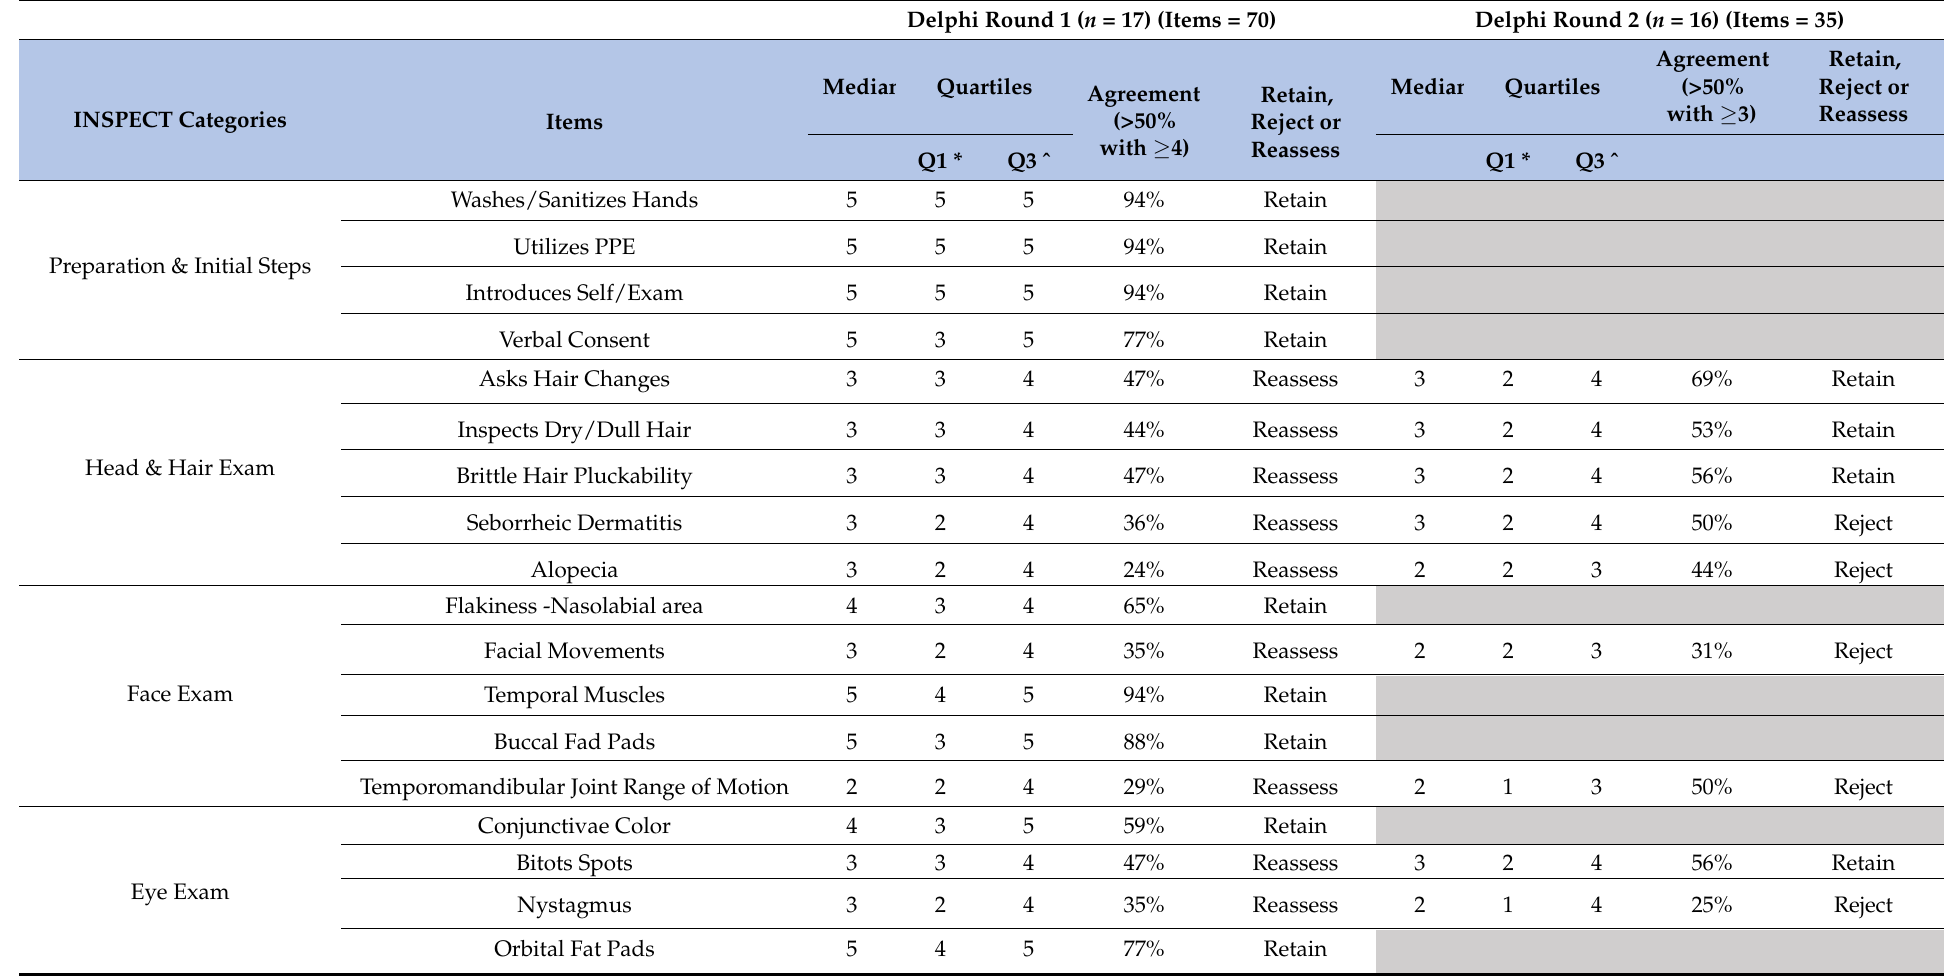
Table 3. Delphi Consensus on the Content Validity of the